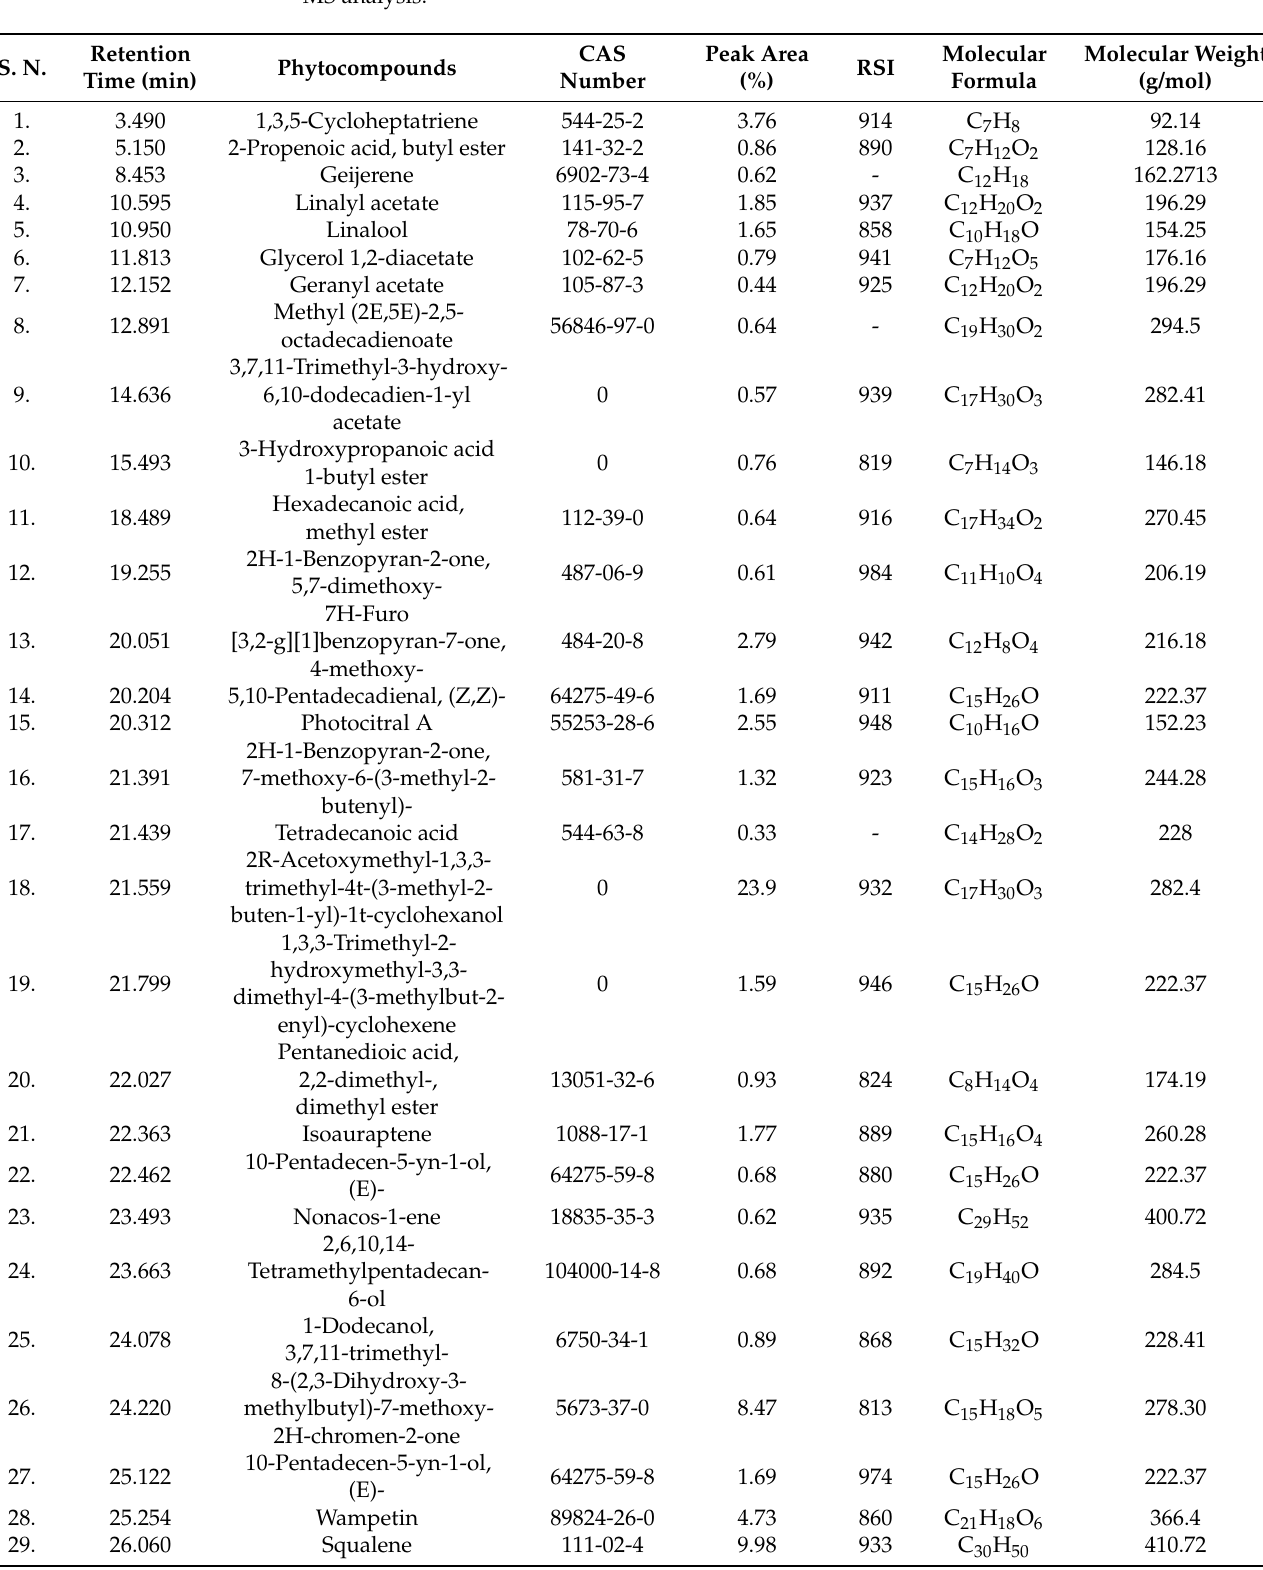
Table 2. Bioactive compounds of methanolic leaf extract of Skimmia anquetlia identified using GC- MS